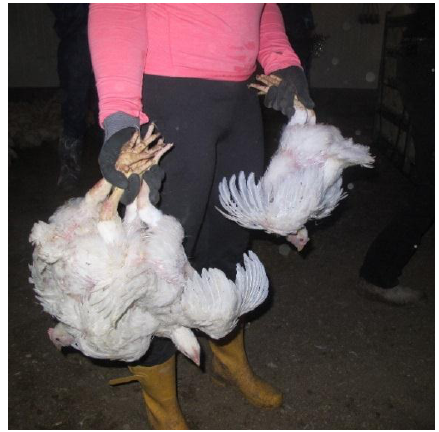
Figure 1. Catching and carrying broilers by a grip in both